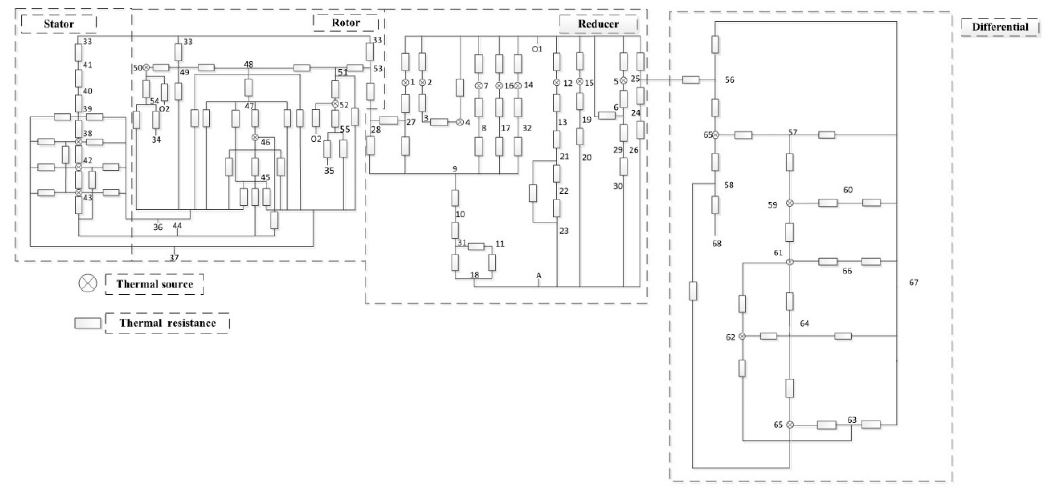
Figure 7. The thermal network diagram of the planetary automobile drive axle. Temperatures of the sixty-eight nodes in the planetary automobile drive axle are ob- tained using the TNM, and the TFD is drawn in Figure 8.